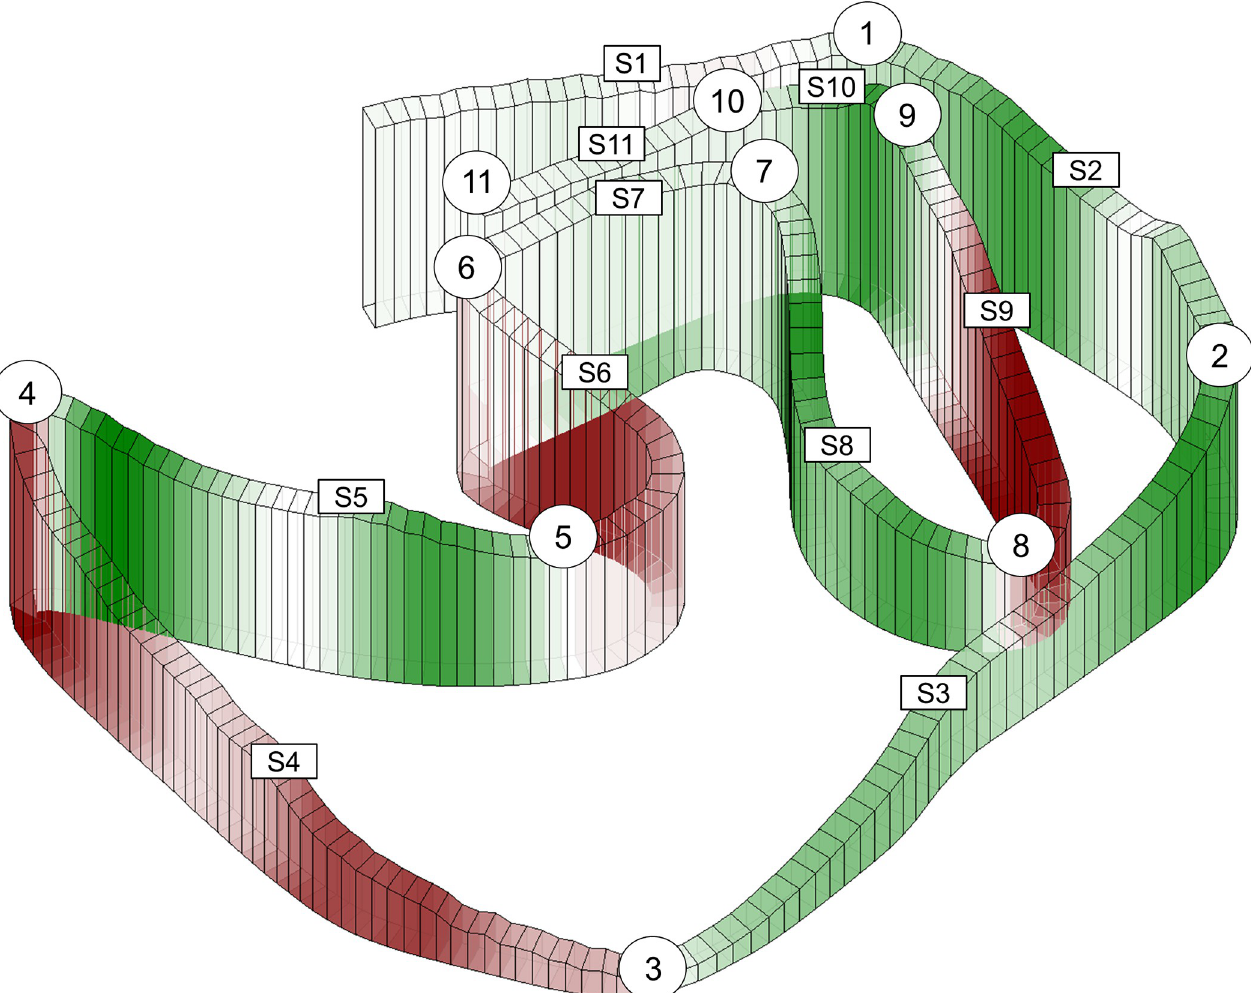
Fig 1. Racecourse. Three-dimensional illustration of the 1.7-km racecourse examined in the current study where the 11 segments (S1-S11) and 11 checkpoints are shown along the racecourse from start to finish. The colours represent terrain; uphill (red), flat (white), downhill (green), respectively.